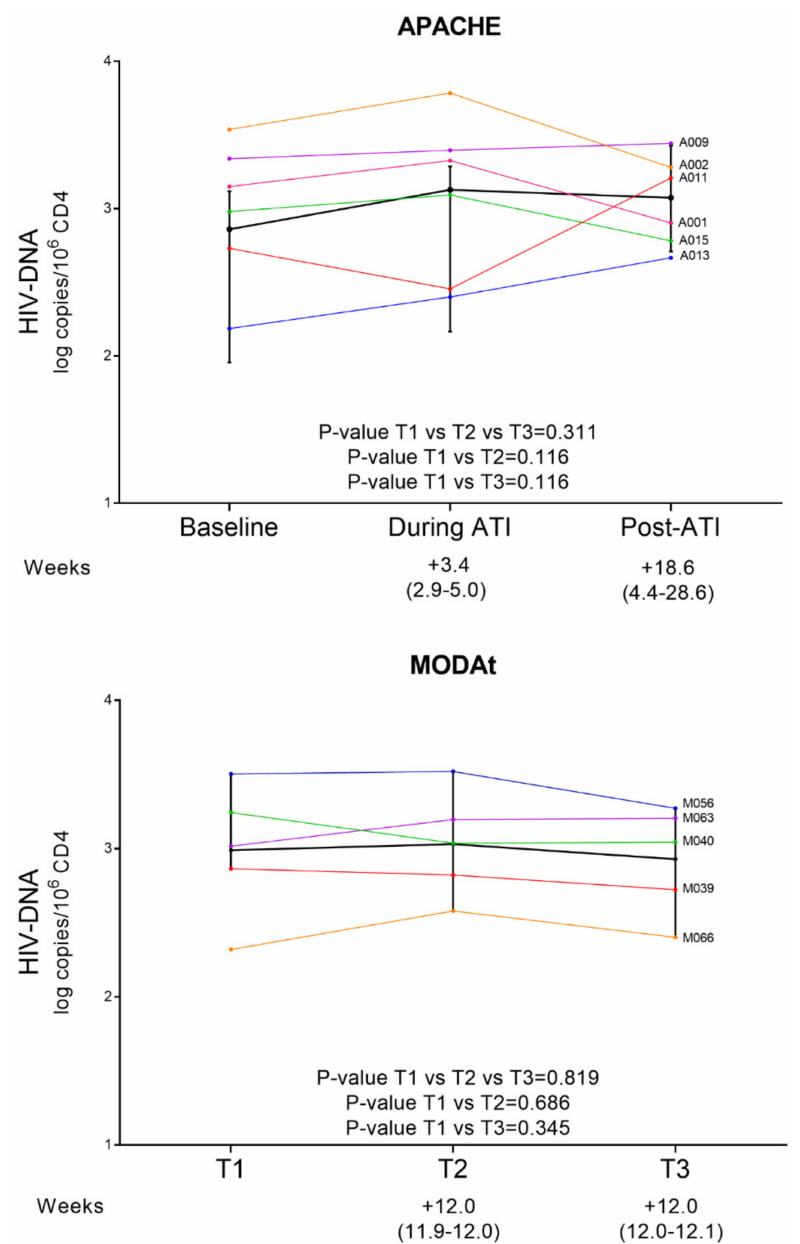
Figure 1. Total HIV-DNA of APACHE and MODAt patients at T1, T2 and T3. Each line represents a patient. The black line represents the mean value at each time point, accompanied by error bars. Table 1 to T2 and from T2 to T3 is expressed in weeks (median, IQR). p -value T1 vs. T3: Wilcoxon-test; p -value T1 vs. T2 vs. T3 Friedman